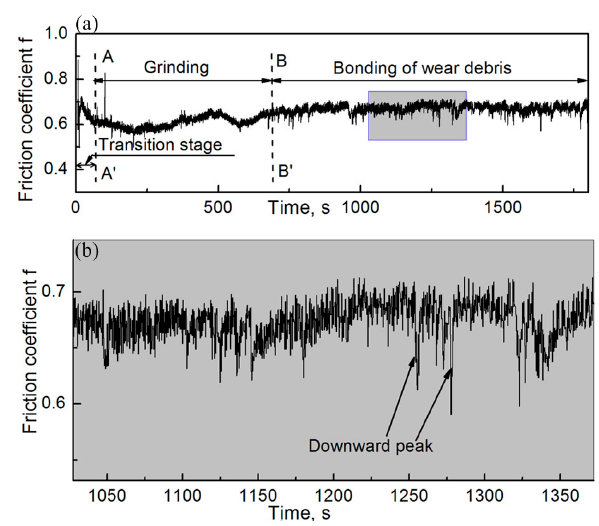
Figure 18 Friction–coefficient evolution during the friction process without using the RD; H = 26.1 × 10 3 A/m. ( a ) Complete drawing and ( b ) local enlarged drawing of the shadowed region in (a).